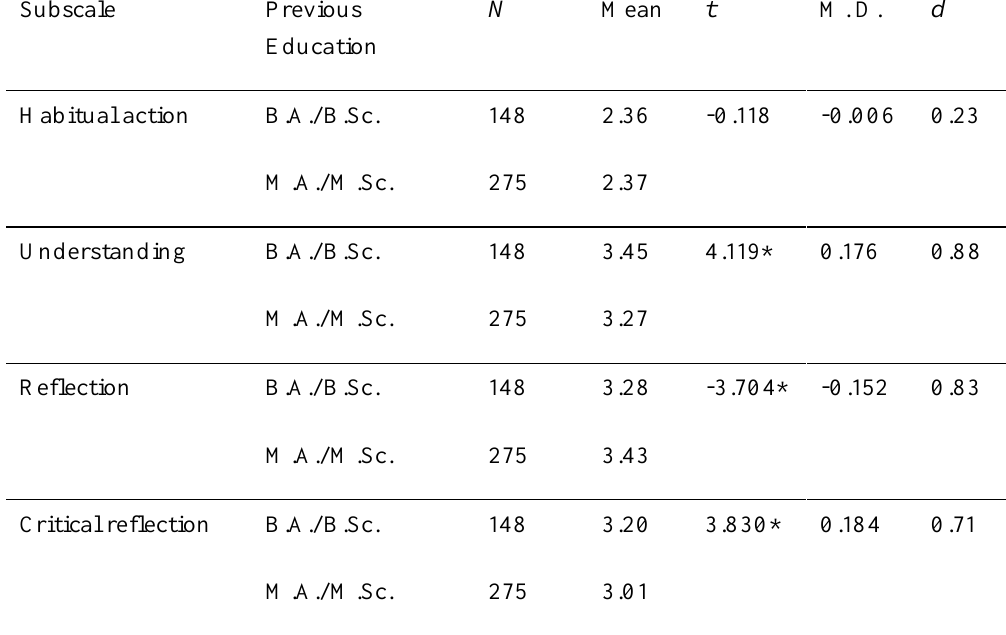
Table 7 Impact of AIOU Students’ Previous Education on their Thinking Patterns Subscale